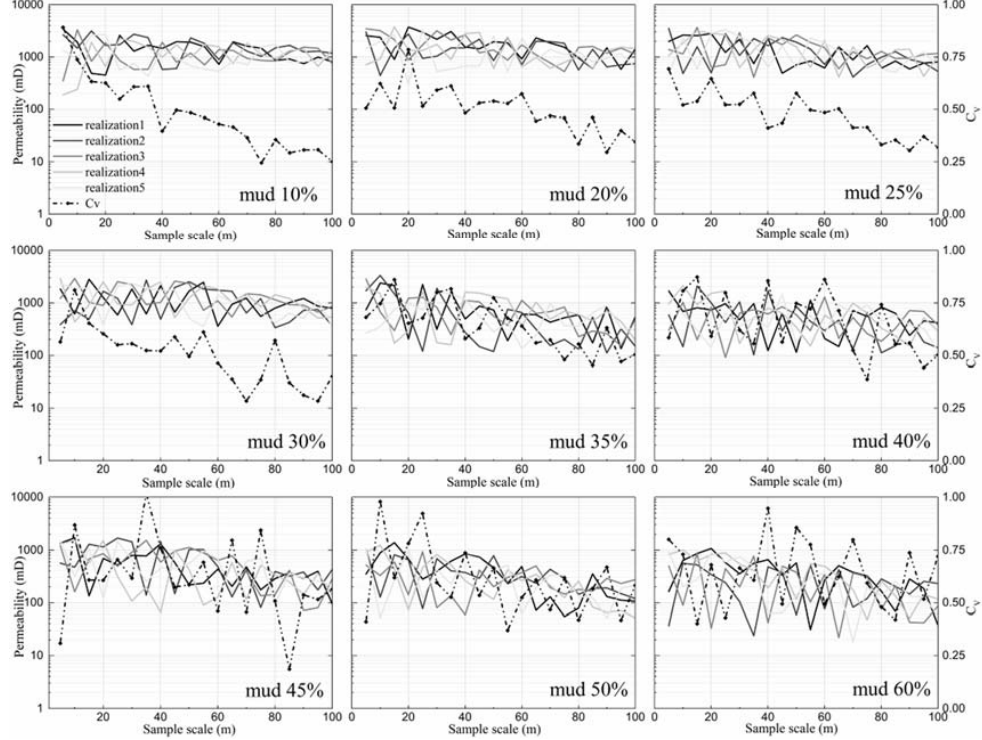
Figure 9. How the horizontal permeability ( k h ) varies with the increase in sample size for ISWZs with varying width.